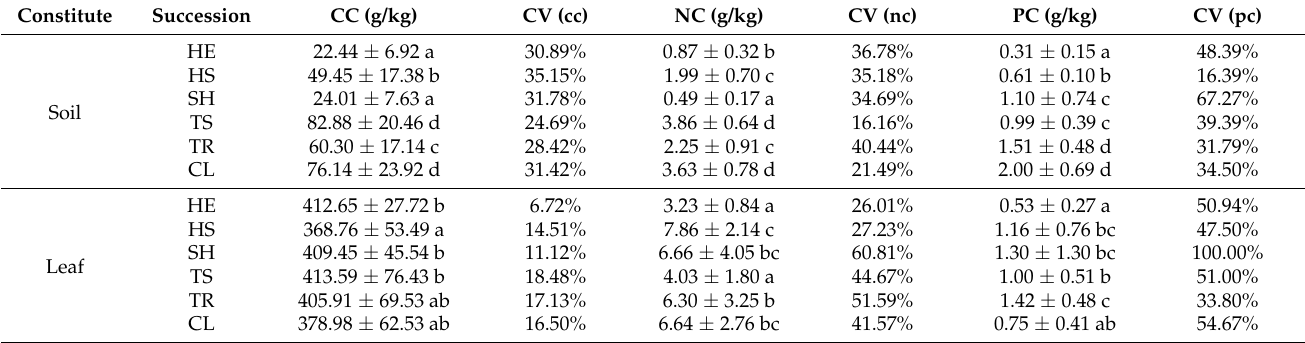
Table 3. Characteristics of leaf and soil C, N, and P contents at different recovery stages.